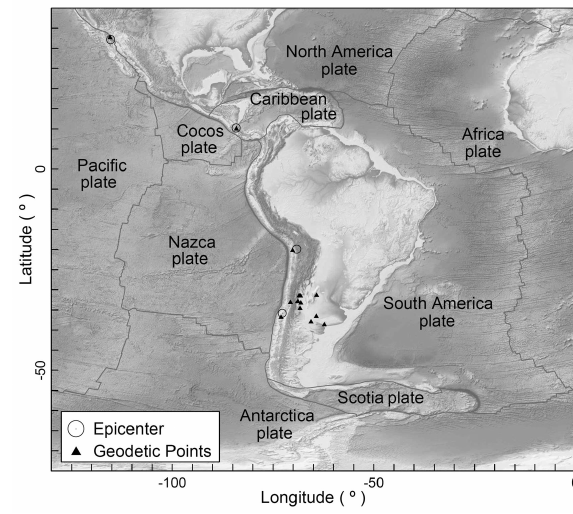
Figure 3. Unstable geodetic points associated with seismic